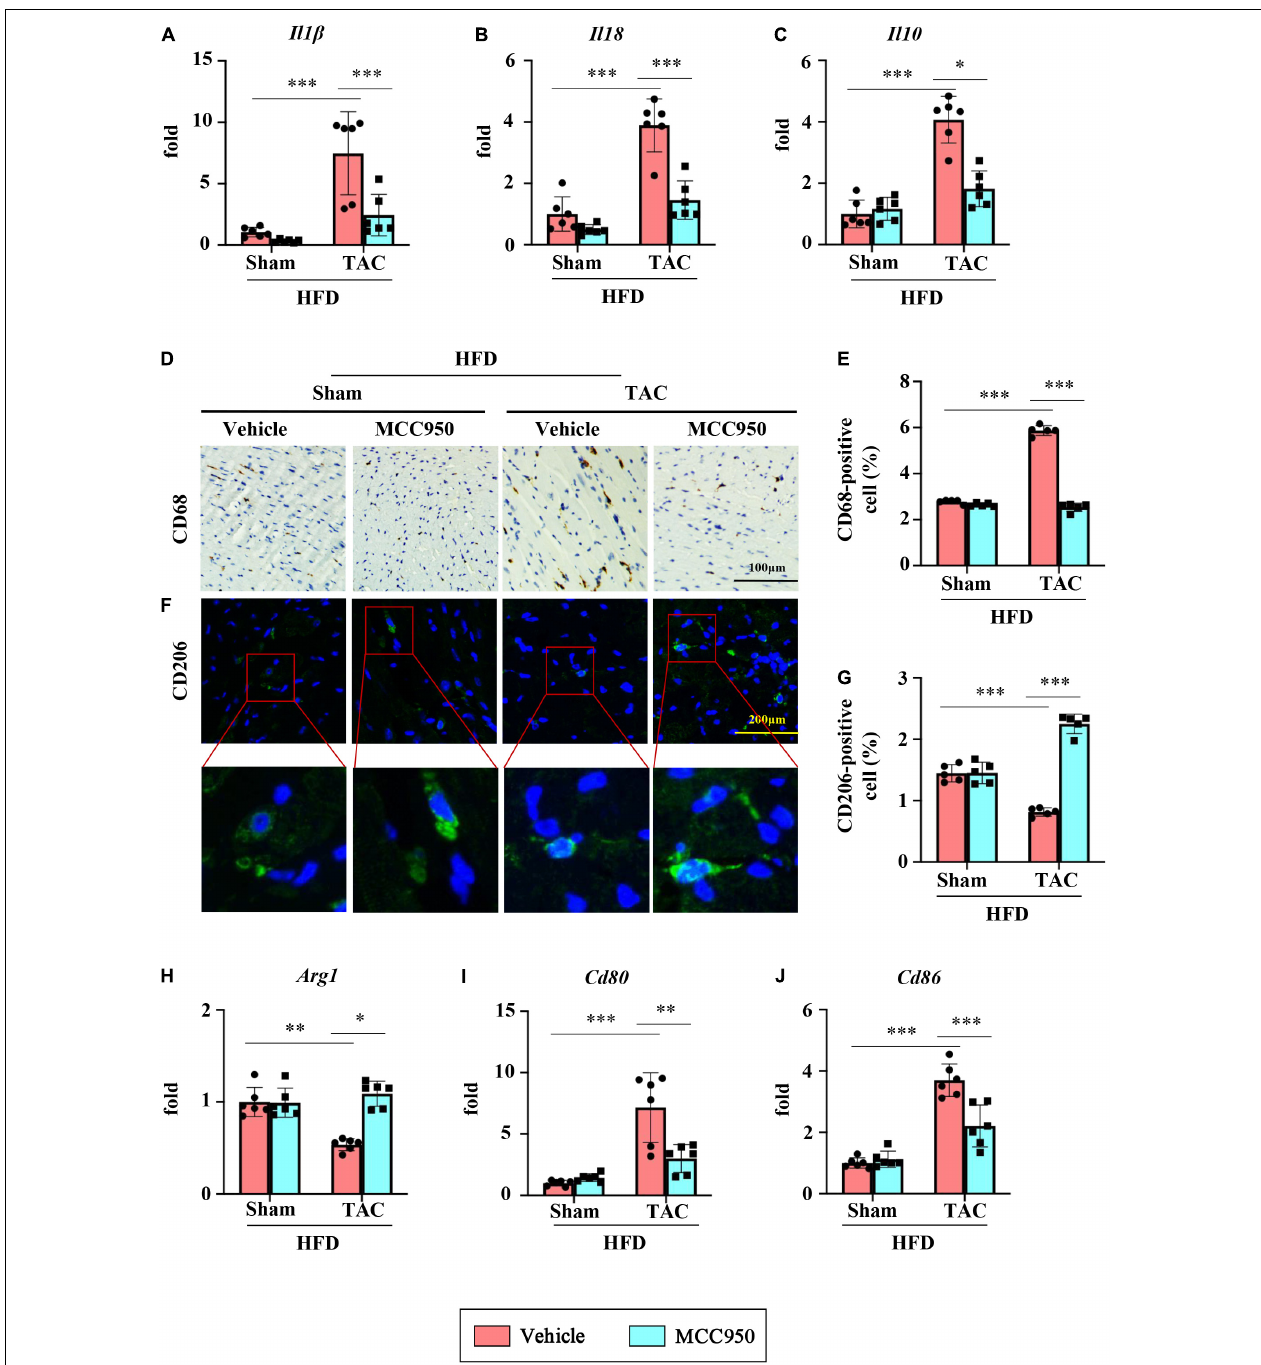
FIGURE 4 | MCC950 attenuates pressure overload-induced cardiac inflammation. Relative mRNA expression of (A) IL1 β , (B) IL18, and (C) IL10, n = 6. (D,E) Immunohistochemical analysis of CD68, n = 3. (F,G) immunofluorescence analysis of CD206, n = 3. (H–J) Relative mRNA expression of Arg1, CD80, and CD86, n = 6. IL, interleukin; Arg1, arginase 1. ∗ p < 0.05, ∗∗ p < 0.01, ∗∗∗ p <